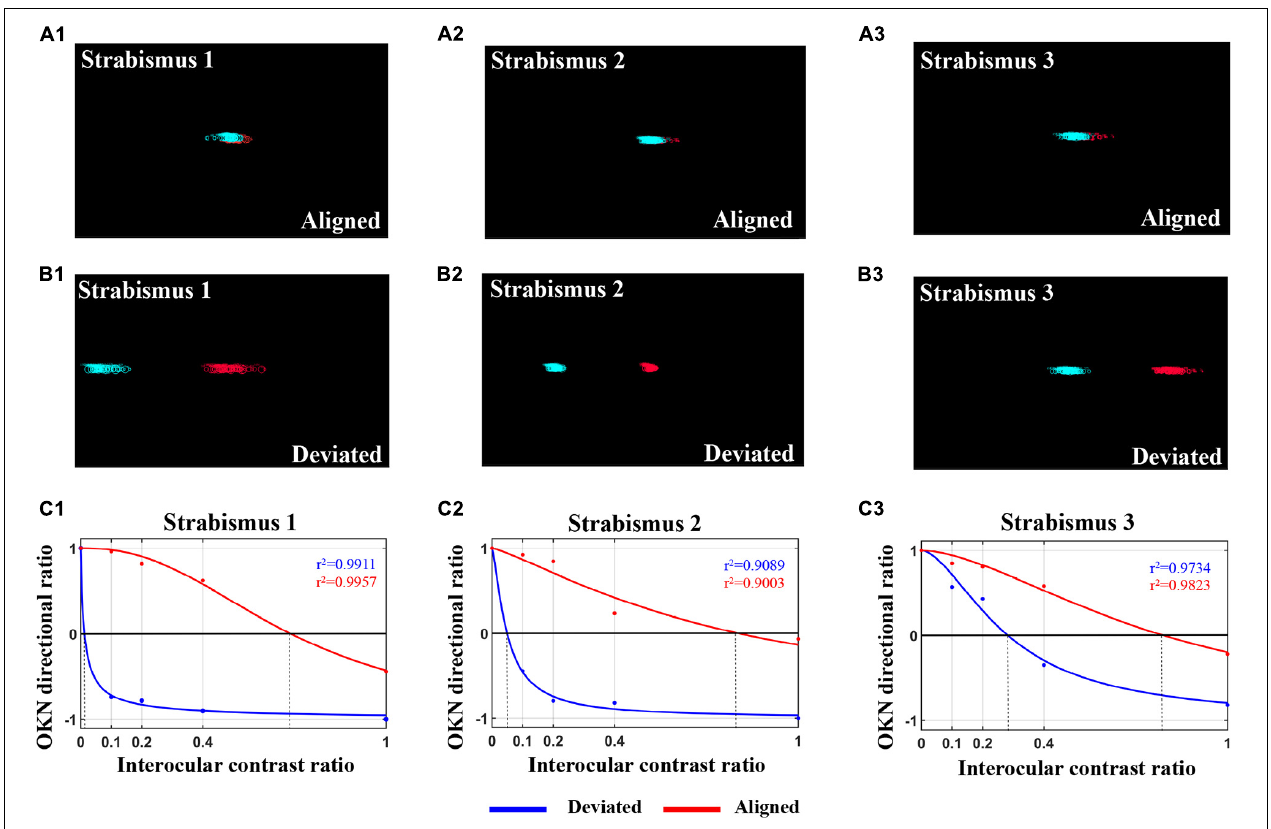
FIGURE 5 | The OKN distribution in IXT subjects when kept alignment shows deviation. (A1–3) The eye movement pattern of three IXT subjects when kept alignment during the dOKN test, as recorded by an eye tracker. (B1–3) The eye movement pattern of three IXT subjects when showing deviation during the dOKN test, as recorded by an eye tracker. (C1–3) The fitting curves drawn by dOKN of three IXT subjects when kept alignment (red line) or manifesting exotropia (blue line).